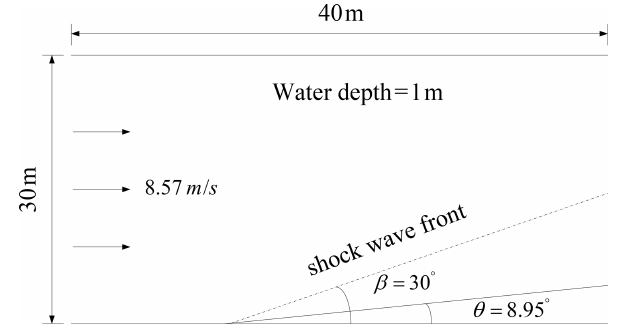
Figure 6. Oblique hydraulic jump: definition sketch.